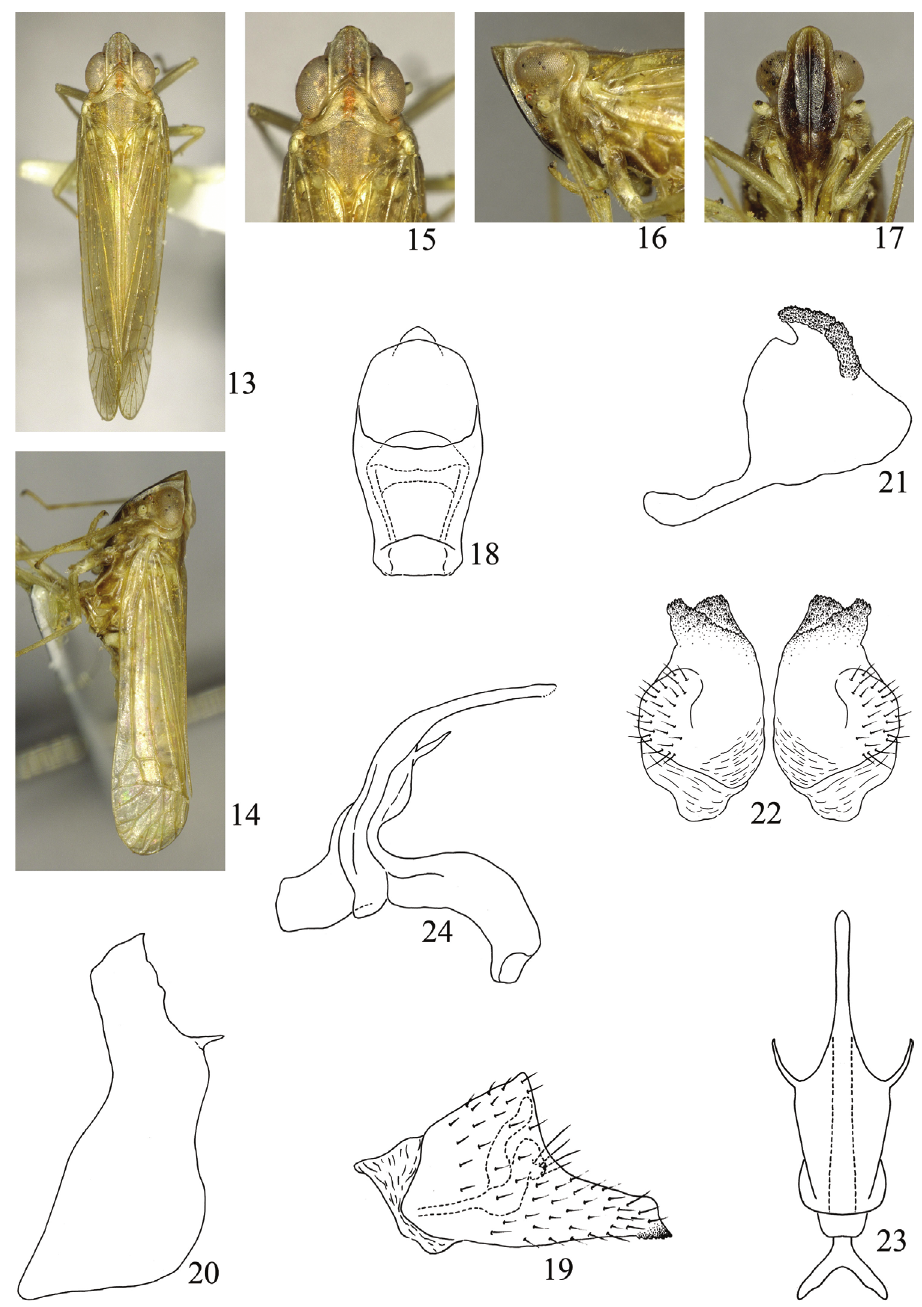
Figures 13–24. Symplanella hainanensis sp. n. 13 Male habitus, dorsal view 14 Male habitus, lateral view 15 Head and thorax, dorsal view 16 Head and thorax, lateral view 17 Face 18 Male anal seg- ment, dorsal view 19 Male anal segment, lateral view 20 Male pygofer, lateral view 21 Style, lateral view 22 Styles, posterior view 23 Aedeagus, dorsal view 24 Aedeagus, lateral